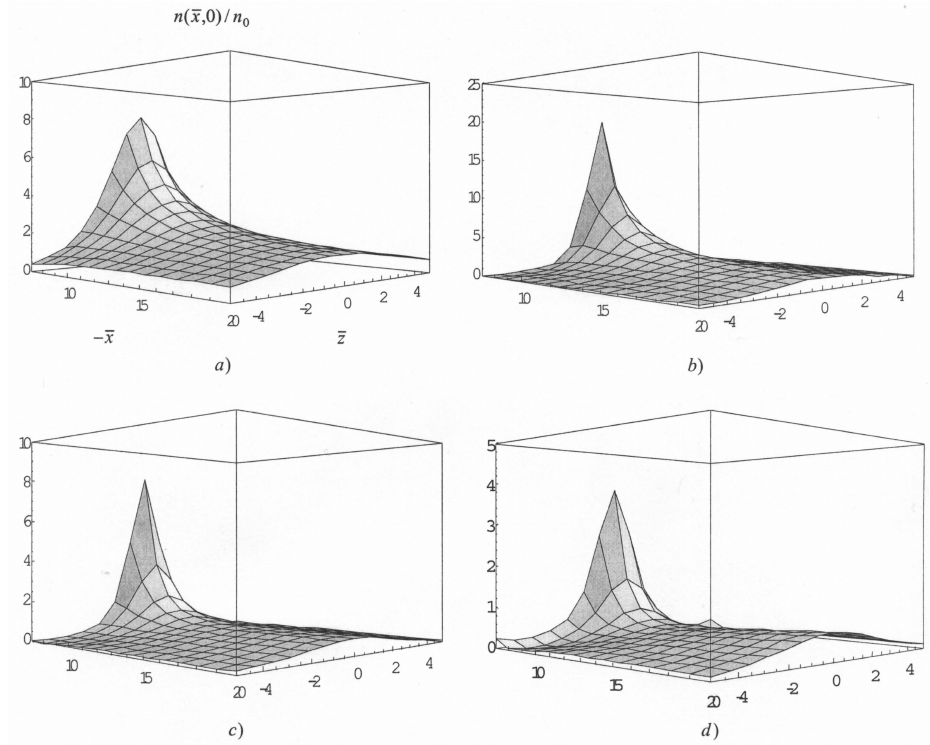
Fig. 3. Dimensionless plasma density (current density) relief: n(x,z)/n 0 = j(x,z)/j 0 . The values x b and B ∞ are fixed: x b = − 7, B ∞ = 3 · 10 2 (nT). (a) γ = − 1 . 5, m = 0 . 15; (b) γ = − 2 . 5, m = 0 . 25; (c) γ = − 3 . 5, m = 0 . 35, x R = − 15 , 6; (d) γ = − 4, m = 0 . 4, 7 x R = − 12 . 1. Note the difference in vertical scales in the upper and lower